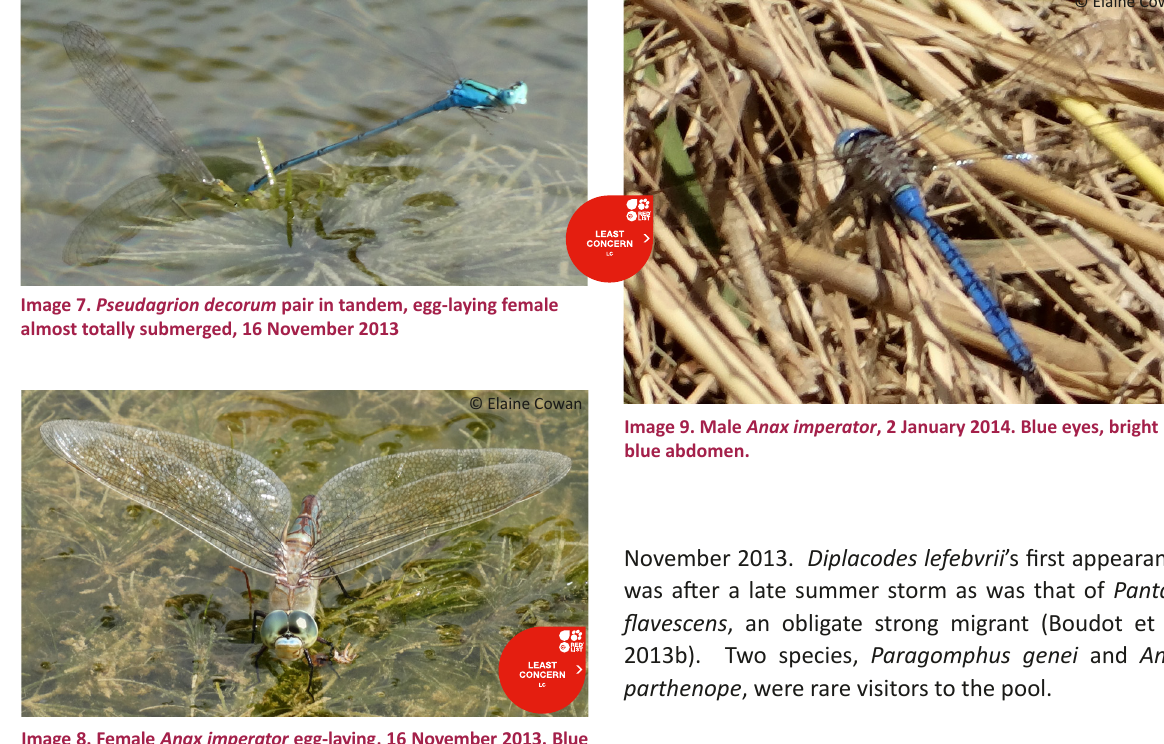
Image 8. Female Anax imperator egg-laying, 16 November 2013. Blue on frons and bluish-green eyes. Wings tinged brown. Blue on abdomen.